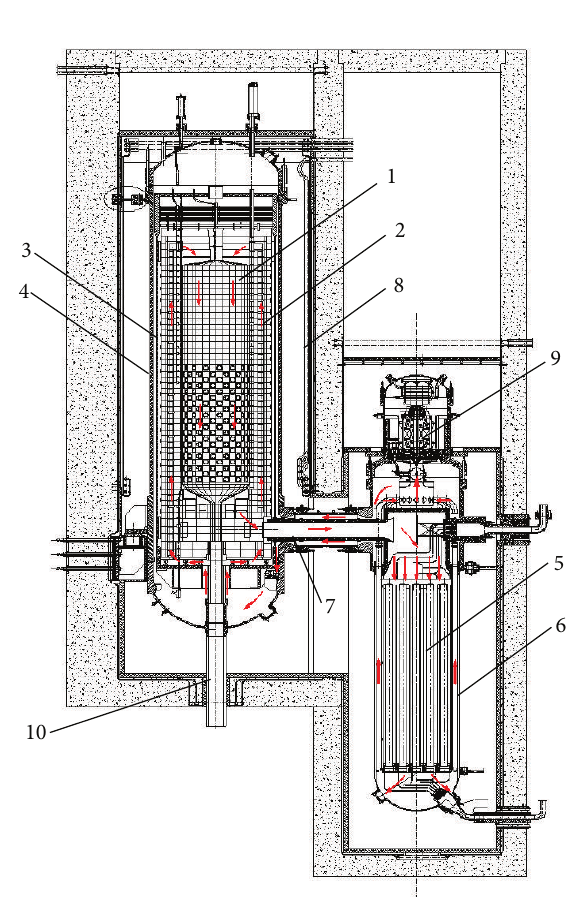
Figure 1: Cross section of the primary circuit of the HTR-PM. (1) Reactor core; (2) side reflector and carbon thermal shield; (3) core barrel; (4) reactor pressure vessel; (5) steam generator; (6) steam generator vessel; (7) coaxial gas duct; (8) water-cooling panel; (9) blower; (10) fuel discharging